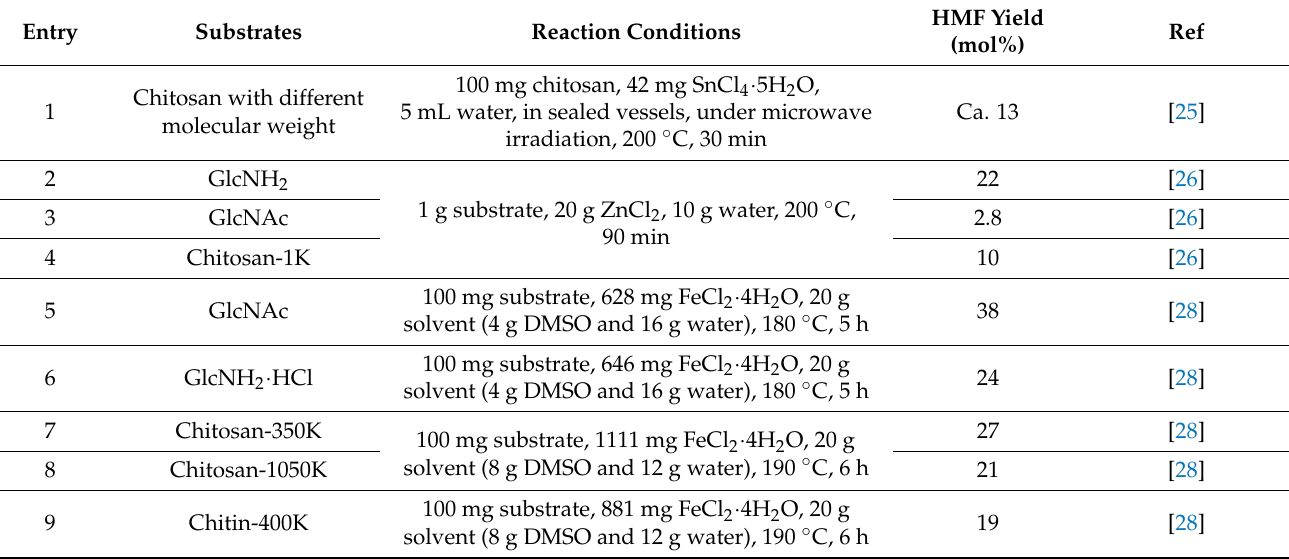
Table 2. Catalytic conversion of chitin biomass to HMF over Lewis acid